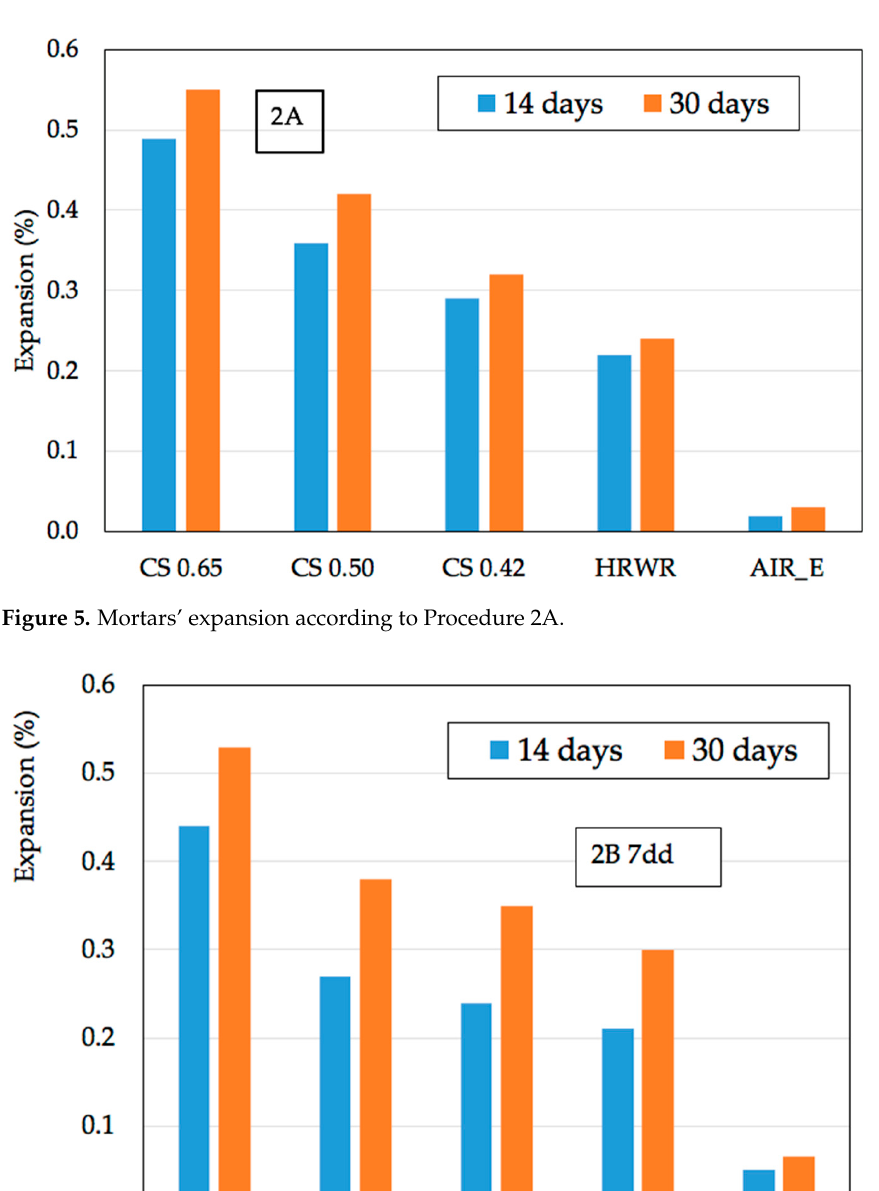
Figure 4. Mortars’ expansion according to Procedure 1.